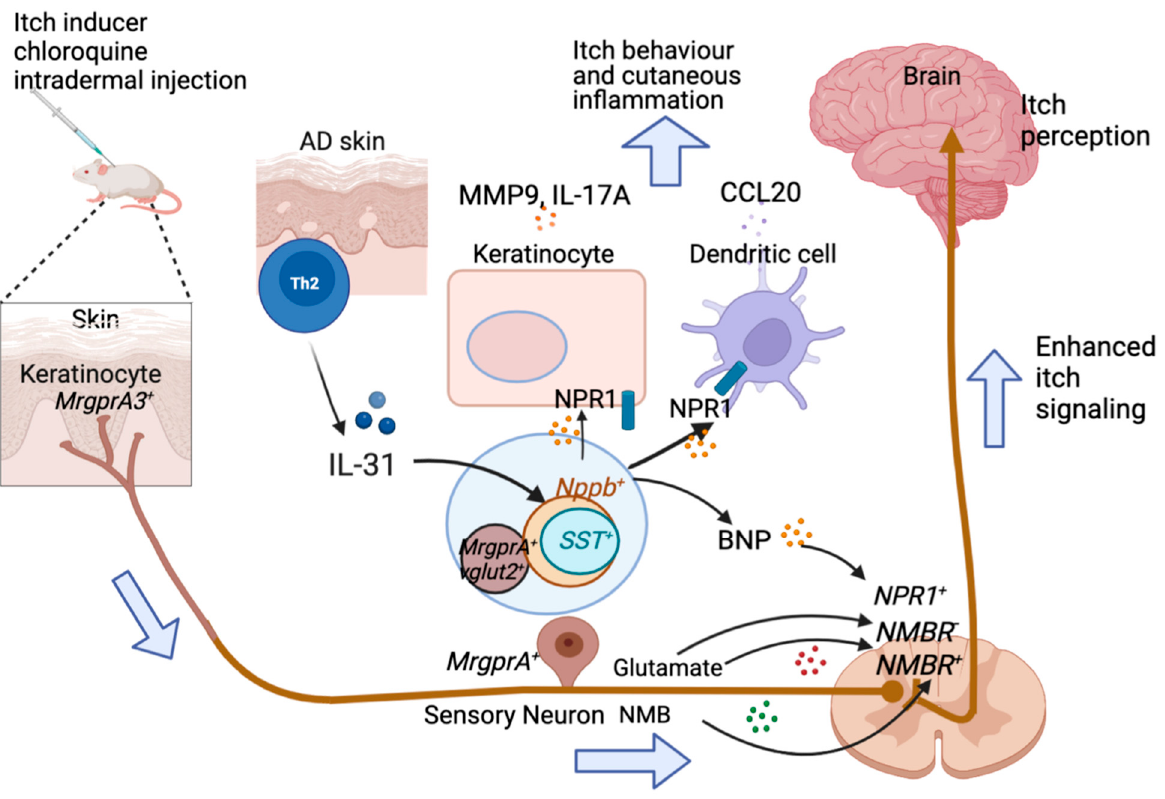
Figure 1. Glutamate and BNP transmit itch through distinct pathways. MrgprA3 + neurons utilize glutamate together with NMB, to transmit itch signal to dorsal horn neurons. Distant from glutamate that activates NMBR + and NMBR - dorsal horn neurons, NMB activates only NMBR + neurons. Instead, BNP is expressed in a separate neuronal subpopulation which also express SST BNP is expressed in a separate neuronal subpopulation which also express SST and IL-31RA. During and IL-31RA. During AD itch, IL-31 induces BNP release from these Nppb + neurons, and the released AD itch, IL-31 induces BNP release from these Nppb + neurons, and the released BNP binds NPR1 + BNP binds NPR1 + dorsal horn neurons to propagate itch signal. dorsal horn neurons to propagate itch